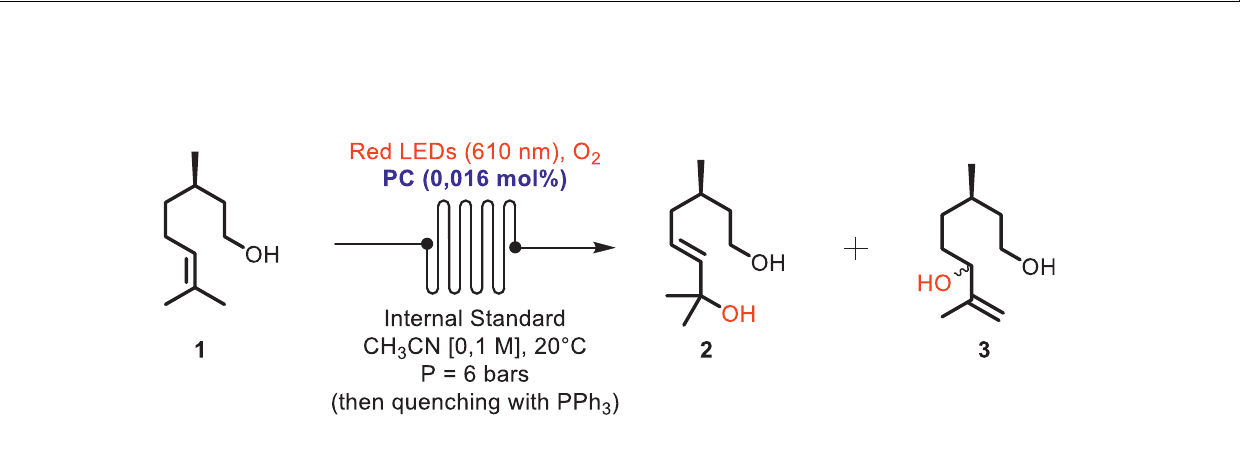
FIGURE 4 | (A) Plots of the conversions of 1 as a function of residence times under homogeneous and heterogeneous conditions in fl ow (in CH 3 CN [0.1 M], Q (O 2 ) (cid:1) 2 ml(n) · min − 1 , p (cid:1) 6 bars) (B) Absorption spectra of the homogeneous reaction media obtained at the outlet of the fl ow reactor at different residence times (in